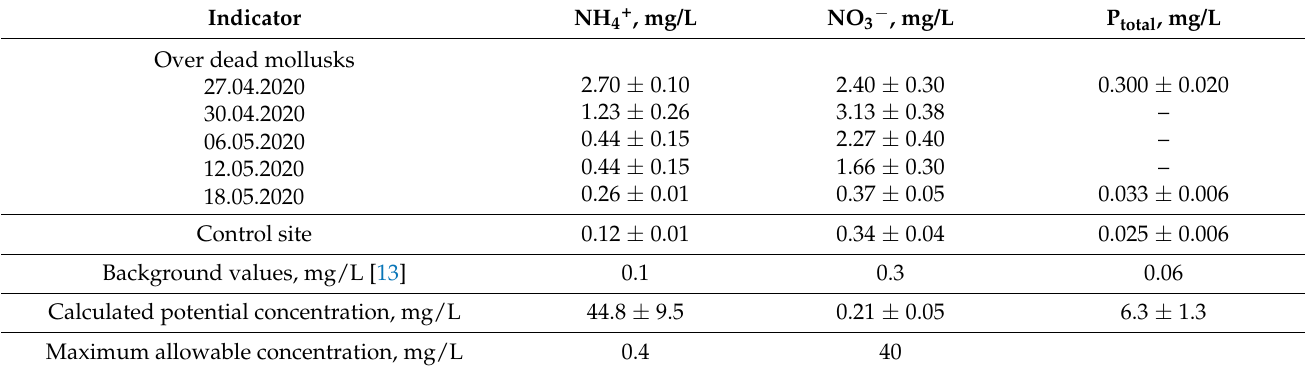
Table 1. Nutrient concentrations in water of the Novosibirsk